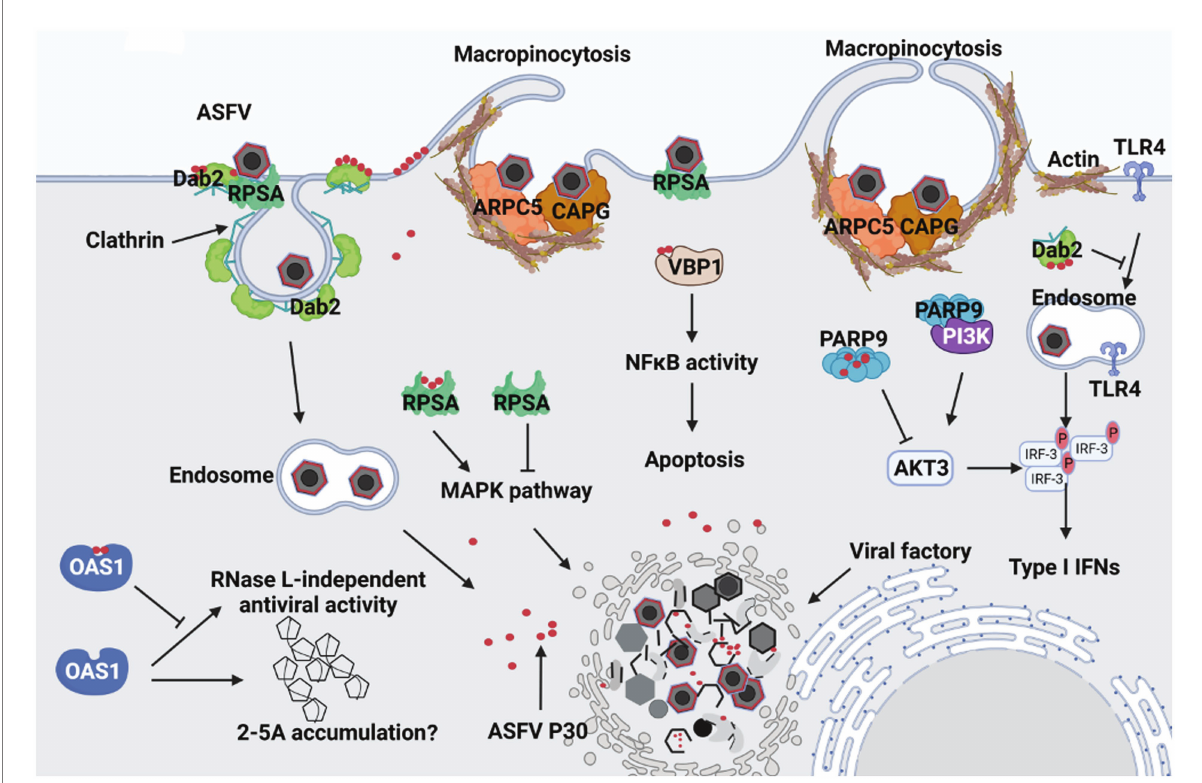
FIGURE 7 Predicted schematic model depicting the interaction between ASFV p30 and host cells. 1. After ASFV attaches to cells, it may bind to Dab2 and RPSA on the cell membrane through the structural protein p30, and then Dab2 recruits clathrin to mediate ASFV endocytosis. 2. p30 binds ARPC5 and CAPG, causing cellular actin rearrangement to trigger macropinocytosis. 3. After viral endocytosis, p30 protein may inhibit the entry of TLR4 into endosomes by recruiting Dab2 and clathrin, and the interaction between PARP9 and p30 may also inhibit the binding of PARP9 to PI3K and AKT3 activation. They ultimately inhibit IRF3 phosphorylation and reduce type I interferon production. 4. p30 may promote viral replication by interacting with RPSA to eliminate the inhibitory effect of RPSA on the MAPK pathway; p30 may prevent RNase L-dependent or independent antiviral responses by interacting with OAS1. 5. p30 can also interact with VBP1, which may enhance the activation of NF- κ B and regulate the occurrence of